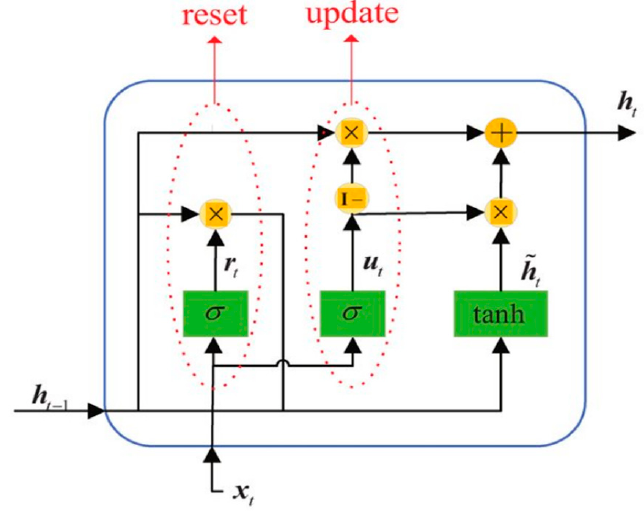
Figure A7. Basic architecture of GRU.